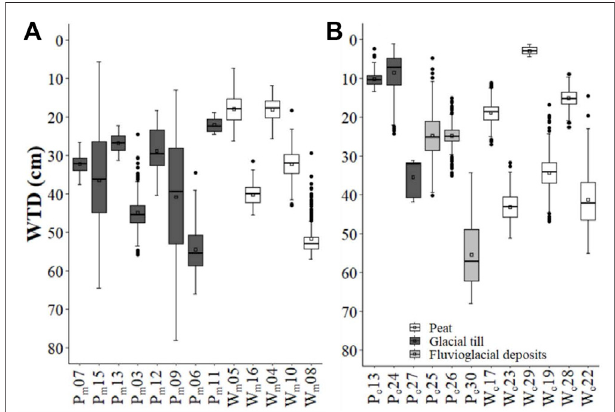
FIGURE 4 | Average daily water table depths (WTD) from June to October (2018 and 2019) for monitored wells (peat) and piezometers (mineral deposits),andforunmonitoredstations(P m 13,P m 12,P c 27,W c 29)usedinthe Darcy fl ow calculation for (A) the Misask peatland and (B) the Cheinu peatland. Squares indicate mean